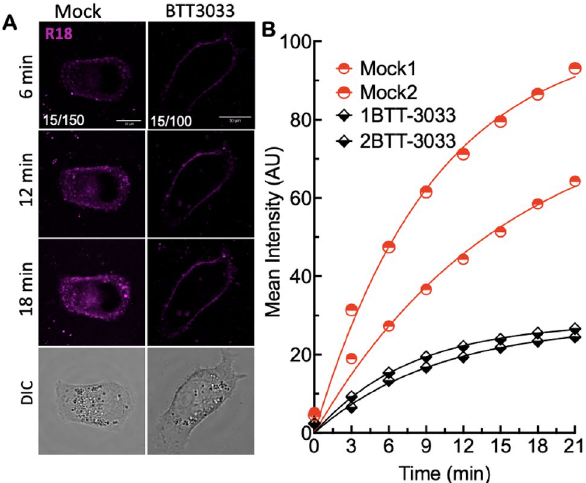
Figure 4. Stabilization of bent closed conformation with aI MIDAS domain binding integrin antagonist inhibits intracellular trafficking of SARS-CoV-2 R18 . ( A ) Live cell imaging of SARS-CoV-2 R18 (magenta) binding and endocytosis shows perinuclear localization of SARS-CoV-2 R18 vesicles. At the same time, the virus is seen to accumulate at the plasma membrane when α 2 β 1 integrins are inhibited by 10 µM BTT 3033. Fluorescence images represent maximum projections of five confocal z slices. Mock and BTT 3033 treated samples are shown with different lookup tables (LUT) since binding in treated cells was lower than untreated cells. LUT lower/ upper values are presented in the lower-left corner of 6-min timepoint images. Scale bars, 10 µm. ( B ) Traces function with arbitrary constants for appearance purposes. Imaging data were repeated at least three separate